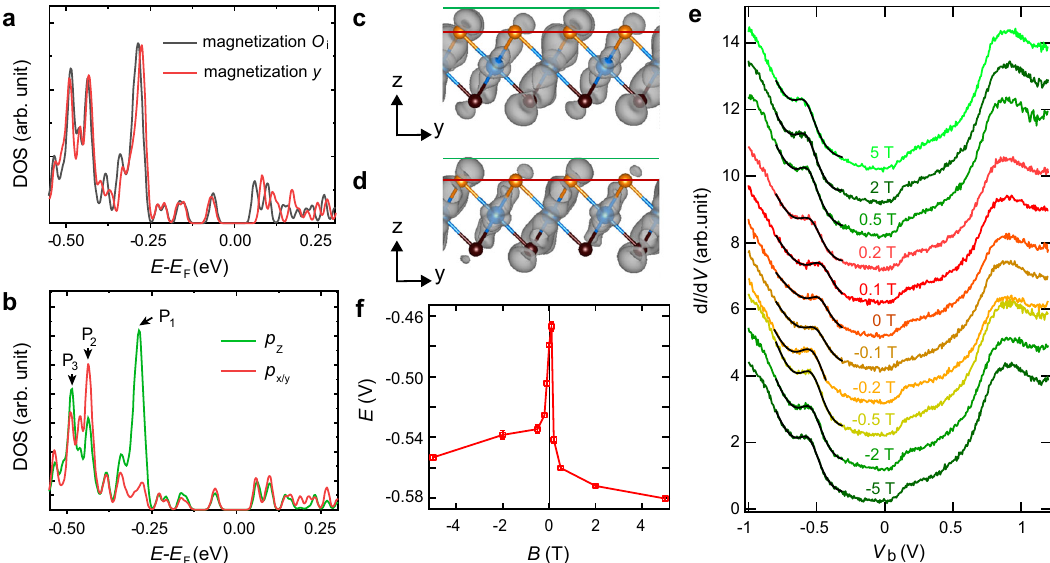
Fig. 4 Electronic characteristics coupled with magnetism. a DOS of the ML CrTe 2 supported on bilayer graphene, where the magnetic moment of each Cr cation is oriented along with the O o (the easy axis) and y (secondary easy axis) directions. b DOSs projected on the Te- p z and p x/y orbitals in the ML CrTe 2 with Cr magnetic moments along the O o axis. Characteristic peaks P 1 , P 2 and P 3 are marked. c , d Wavefunction norms of the P 1 peak with the Cr magnetic moments along with the O o ( c ) and y ( d ) directions. The isosurface value of the contours is 0.0002 e /Bohr 3 . Red and green lines indicate the positions of Te cations and the upper boundary of the contours, respectively. e Tunnelling spectra ( V b = − 1 V, I t = 100 pA, V mod = 14.14 mV rms ) of the same location indicated in the green cross of Fig. 2d obtained with the same micro Cr tip at various magnetic fi elds. The black curves are fi tted to the peaks around − 0.5 eV with a Lorentz shape and a polynomial background. There is a conductance shoulder at about 0.1 V, which is also observable with a W tip (Supplementary Fig. S2). f Statistics of the fi tted peak energies of ( e ) against the magnetic fi eld, where the error bars are from the fi